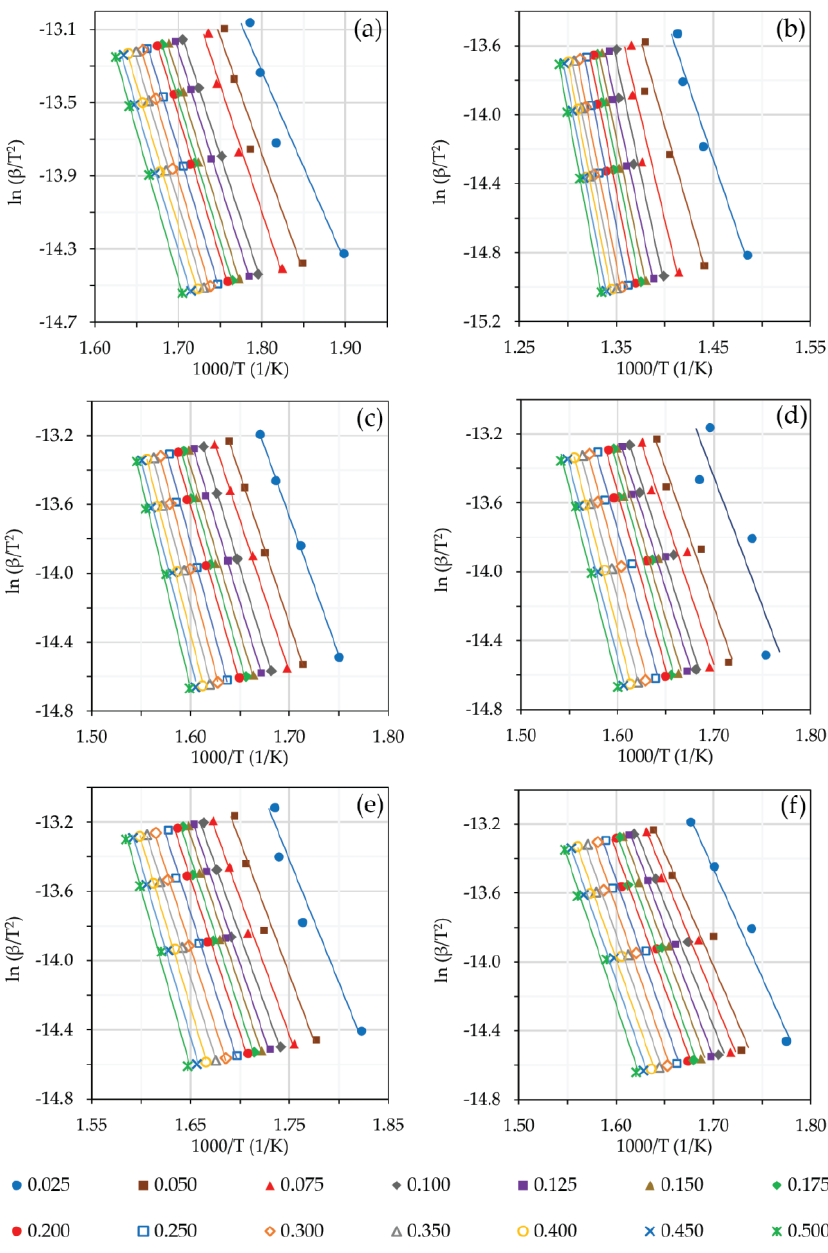
Figure 8. Plots obtained from the TGA curves at different degrees of conversion of ( a ) PLA, ( b ) PP, and PLA/PP blends with LNR−g−MMA of ( c ) 0.0, ( d ) 2.5, ( e ) 5.0, and ( f ) 10.0 phr based on the KAS method.